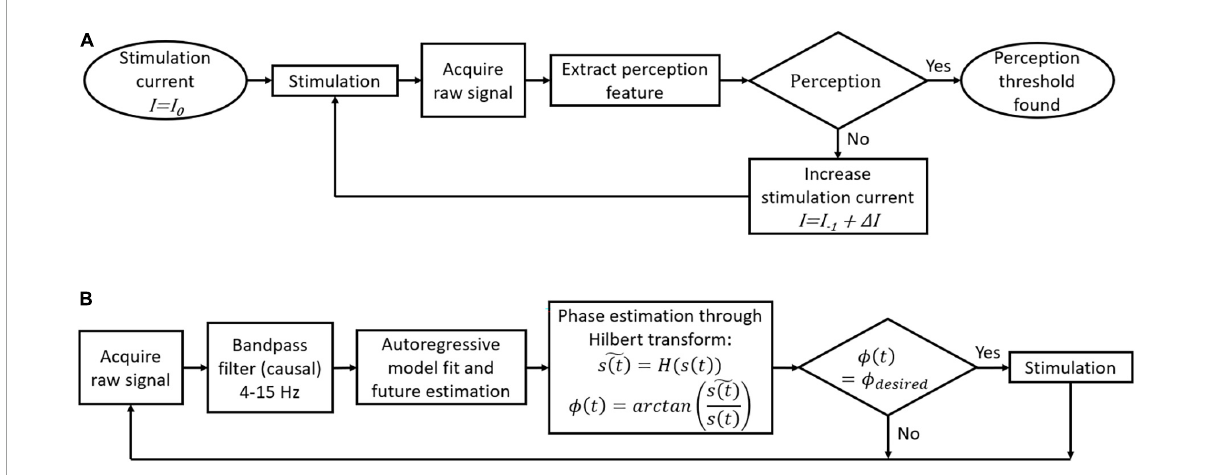
FIGURE2 Flowcharts of possible closed-loop algorithms for a cortical visual prosthesis. (A) Automatic threshold adjustment for perception. (B) Local field potentials (LFP)-phase locked